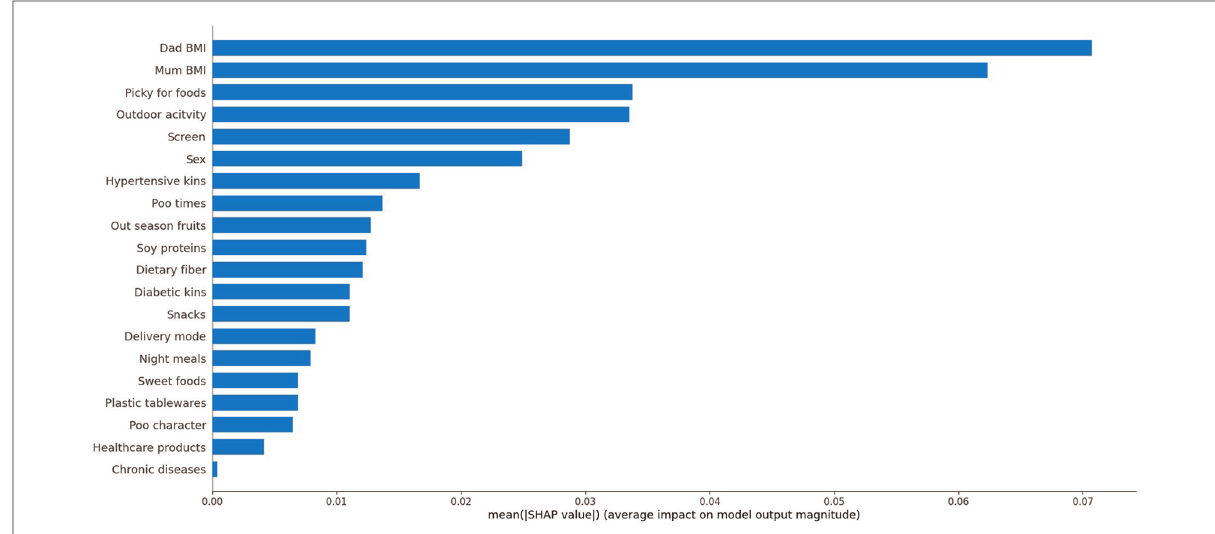
FIGURE 2 The ranking importance of top 20 factors associated with central obesity among school students.